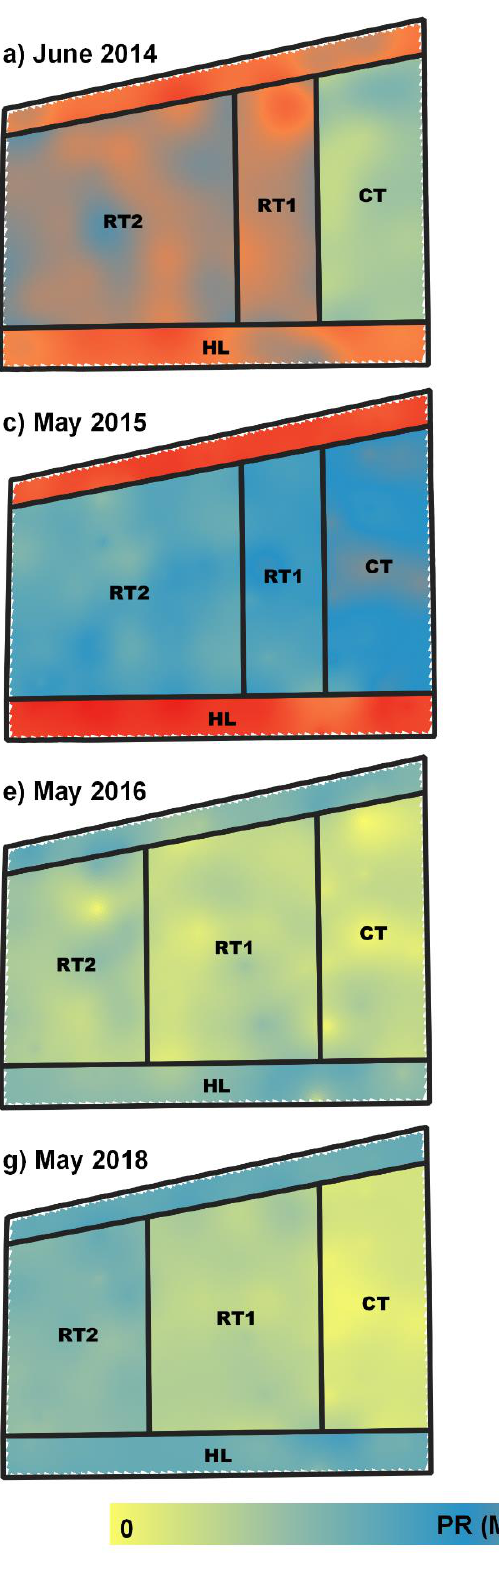
Figure 5. Predicted penetration resistance (PR) in the depth of 16–25 cm using Multiple Linear Regression (MLR). Conventional tilled plot (CT), both reduced tilled plots affected by one-time inversion tillage (RT1: chisel plough; RT2: disc harrow) and the headlands (HL).